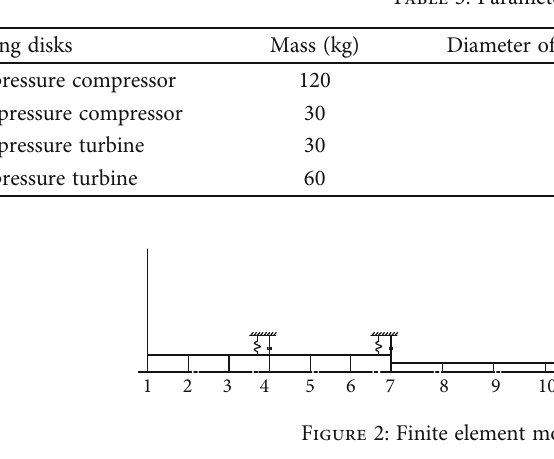
Table 3: Parameters of rotating